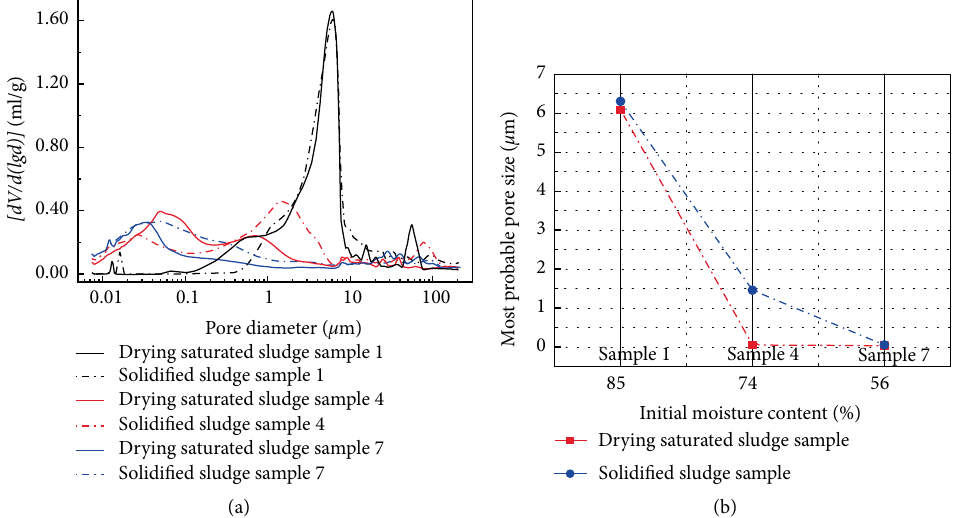
Figure 6: MIP results of solidified sludge with different initial moisture contents: (a) pore distribution density; (b) most-probable pore